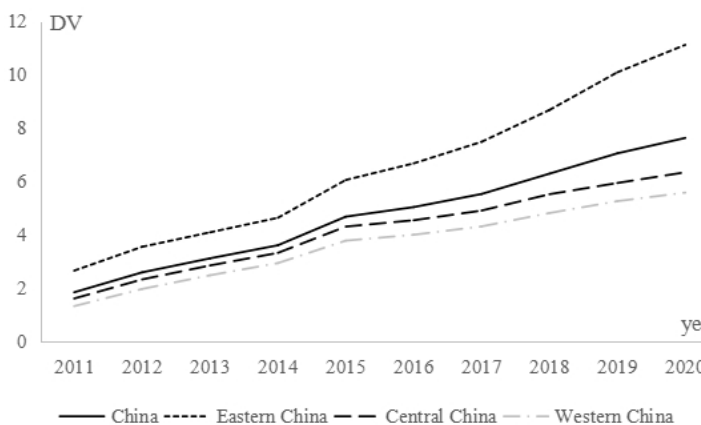
Figure 1. Trends in the level of digital development in rural areas.